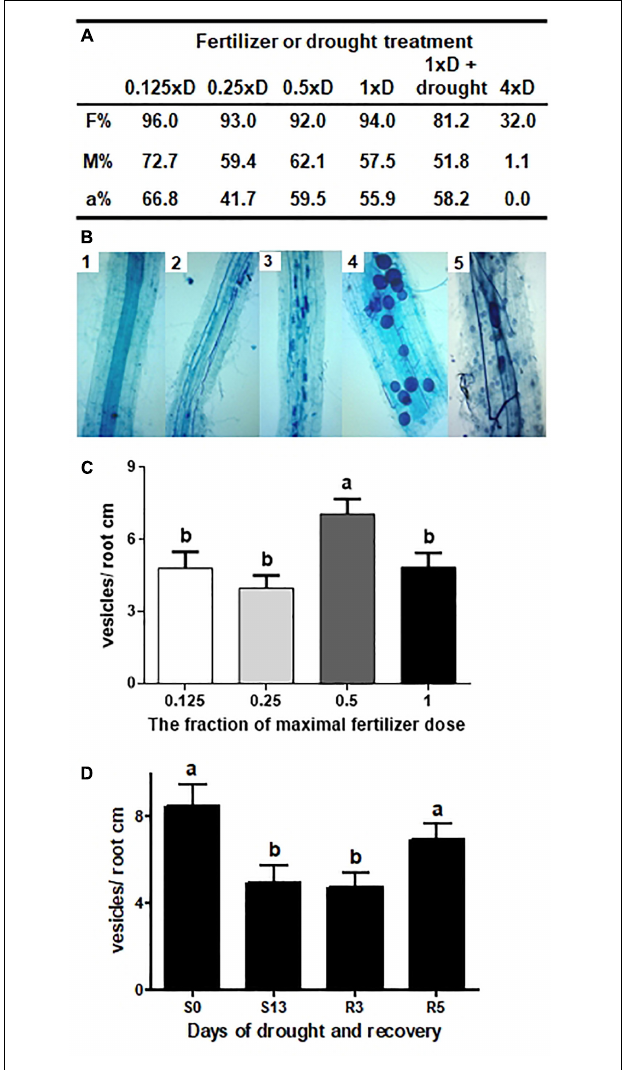
FIGURE 2 | Long-term intraradical hyphae vitality under different fertilization and drought regimes. (A) Fertilizer or drought effect on hyphal root colonization and arbuscules abundance. F% – frequency of fungal structures in the root system, M% – intensity of the mycorrhizal colonization, a% – arbuscular abundance in colonized parts of root fragments, after 6 weeks on 0.25xD fertilizer dilution and additional 4 weeks on fertilization levels annotated in the table (10th week after sowing). Drought impact was examined after additional 2 weeks of drought and 1 week-long recovery; (B) Developmental stages and hyphae vitality. 1: non mycorrhized control roots, 2 and 3: acceleration of arbuscules development between 6th and 8th week of growth on 0.25xD fertilization level, 4: vesicles abundance after additional 4 weeks on 1xD dose, 5: sporulation level at the time of silage harvest (20th week after sowing); (C) Effect of fertilizer dose on AM vesicles abundance, after 6 weeks on 0.25xD fertilizer dilution and additional 4 weeks on fertilization levels annotated in the table (10th week after sowing); (D) Effect of drought and recovery on AM vesicles abundance, after 6 weeks on 0.25xD fertilizer dilution and additional 4 weeks on 1xD fertilization levels annotated in the table (10th week after sowing). Different letters symbolize statistically significant difference between means according to non-parametric Kruskal–Wallis one-way analysis of variance ( p < 0.0001) followed by Dunn’s multiple comparisons test ( p < 0.01). The error bars show the standard error of the mean values ( n = 300–400).